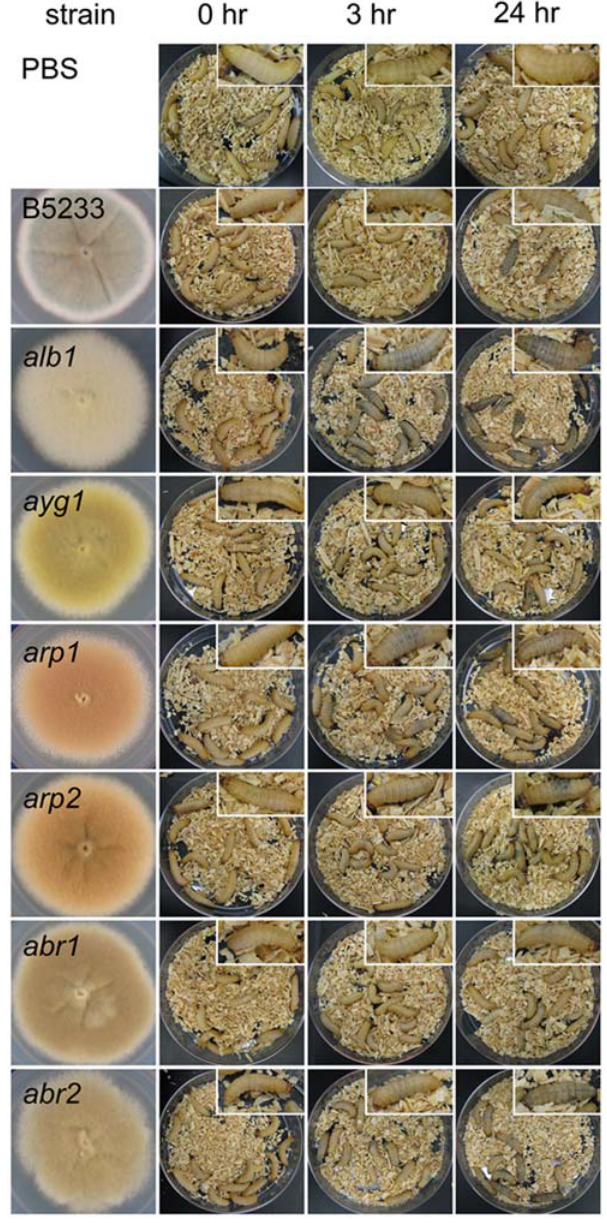
Figure 4. Infection with A.fumigatus color mutants in the B5233 background causes G.mellonella larvae to darken shortly after inoculation. Larvae were infected with A. fumigatus B5233 wild type strain and color mutants alb1 , ayg1 , arp1 , arp2 , abr1 , and abr2 at the concentration of 1 6 10 6 conidia per caterpillar. From left to right are images of A. fumigatus colonies (columns 1), G. mellonella larvae at T=0 h (columns 2), 3 h (columns 3), and 24 h (columns 4) post infection. Insets are close-up images of a representative single caterpillar from the same plate. Larvae injected with PBS buffer are shown on the top for comparison. amplicons of the 19 kb locus (Figure S1), we detected mutations in the melanin biosynthesis gene cluster in several of the Af293 color mutants. For example, # 5 is mutated in alb1 gene, # 48 is mutated in arp1 gene, and # 71 is mutated in abr2 gene. These mutations and their conidial color phenotype are consistent. However, for the majority of the mutants, our screen did not detect any abnormality